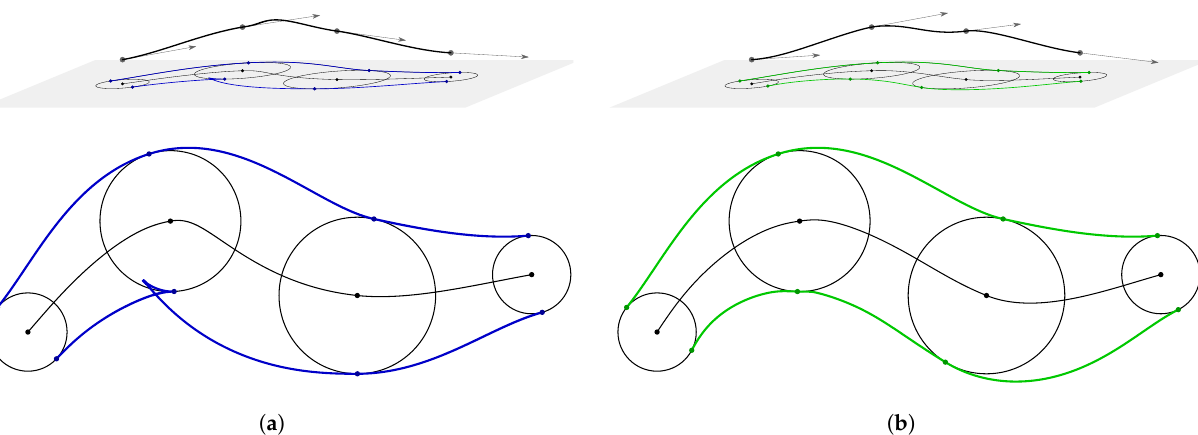
Figure 3. ( a ) Fixing the location of two touching points on each circle, using the method of Kruppa [22]. ( b ) By fixing the location of a single touching point, we get more freedom to modify the shape of the envelope curves. It is possible that this way we eliminate certain